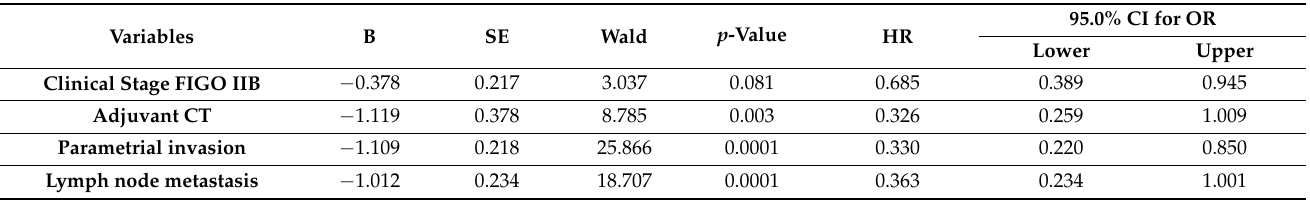
Table 2. Multivariate Cox proportional hazard regression analysis of overall survival